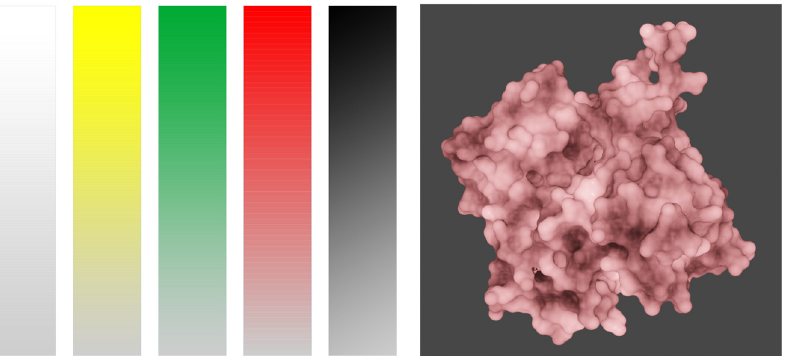
Figure 2: Any color can have a range of intensity ( left ) that can be used to convey properties expressed with a continuum ( right ). Actin monomer (from PDB entry 6anu, B) displaying lipophilic potential calculated and rendered using BioBlender